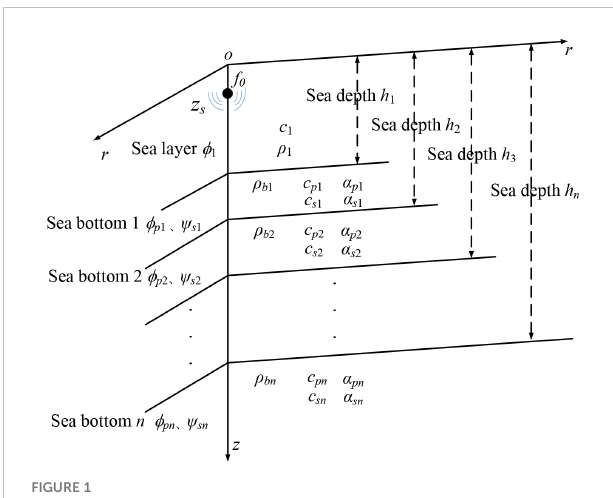
FIGURE 1 The shallow water environment model with an n -layered elastic